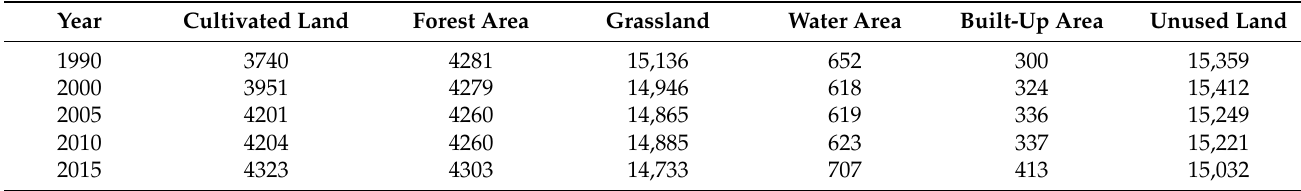
Table 2. Land use types’ areas of Zhangye city in 1990–2015 (km 2 ).